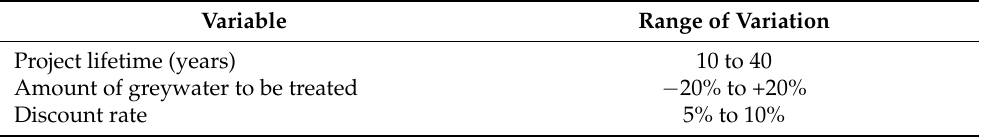
Table 3. Sensitivity analysis parameters. Variable Range of Variation Project lifetime (years) 10 to 40 Amount of greywater to be